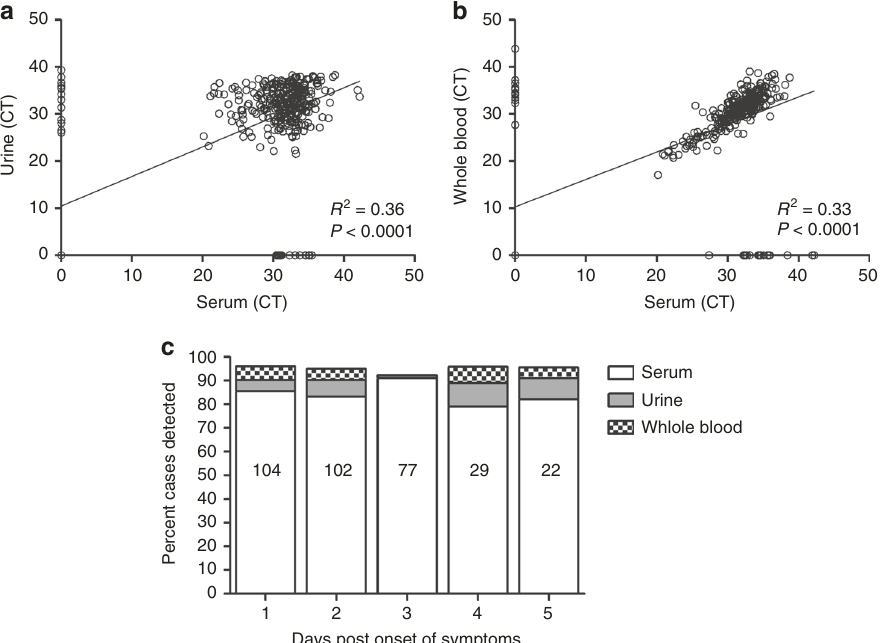
Fig. 5 Clinical performance of the Trioplex assay across specimen types. Clinical specimens collected concurrently from 373 cases with previous Zika determination in the acute stage were tested. RNA was extracted with the MagNA Pure 96 small volume external lysis protocol from 373 case-paired serum, 373 urine, and 345 whole blood-EDTA specimens and tested with the Trioplex assay in multiplex format in the ABI 7500 Fast Dx instrument. a Correlation of CT values between case-matching serum and urine specimens; R 2 = 0.36 p < 0.0001. b Correlation of CT values between case-matching serum and whole blood-EDTA specimens; R 2 = 0.33 p < 0.0001. c Dataset separated by DPO 1 – 5 and percent cases detected by the Trioplex assay in every specimen type. The white bar represents the percent of cases with ZIKV detected in serum specimens. The gray bar represents the percent of ZIKV- positive urine specimens that resulted ZIKV-negative in the matching serum specimen, and the checkered box represents the percent of ZIKV-positive whole blood specimens resulted ZIKV-negative in the matching serum specimen. Both gray and checkered boxes represent the added value of testing more than one specimen type with the Trioplex